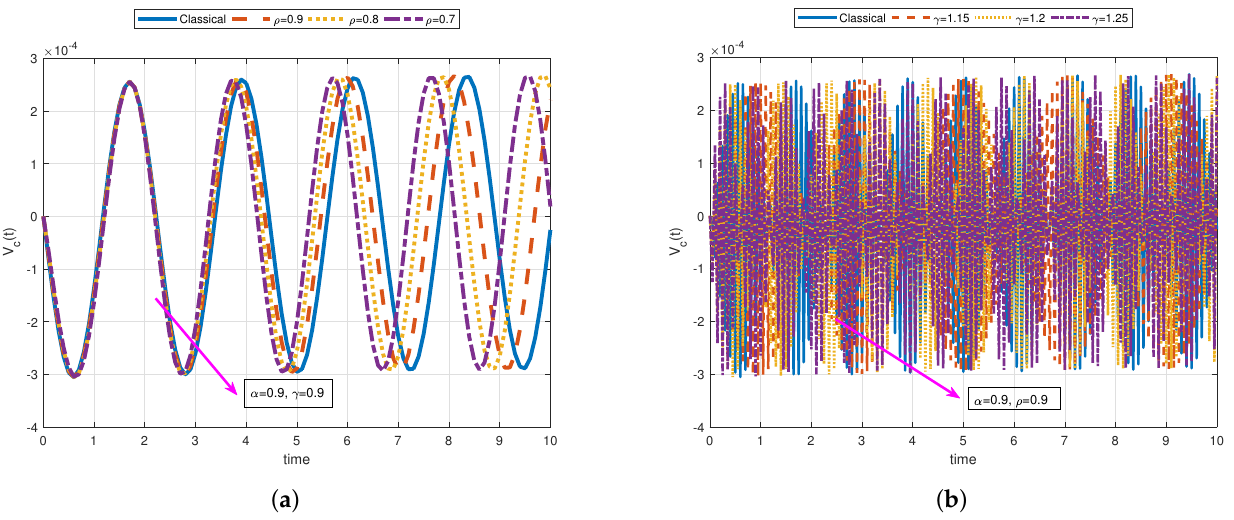
Figure 6. The figure ( a ) corresponds to the function V c ( t ) with an oscillatory source for different values of α , ρ , and γ in order to show the effect of α and γ , and also the figure ( b ) is plotted to show the effect of α and ρ on solution curves when R = 1 Ω , C = 10 F, e 0 = 10 V, and θ = 60 Hz, V c ( 0 ) = 10.